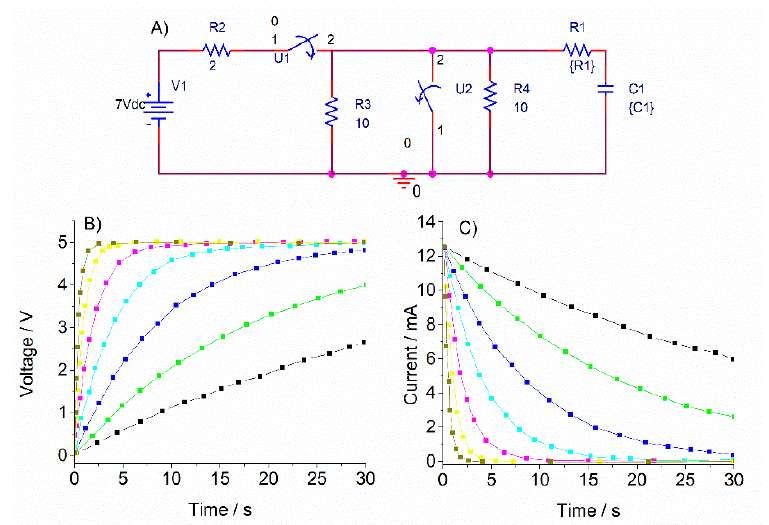
Figure 8. ( A ) Equivalent circuit used for an electrochromic device. ( B ) Simulated voltage–time transients for different R and C values ( C ) Simulated current–time transients for different R and C values.